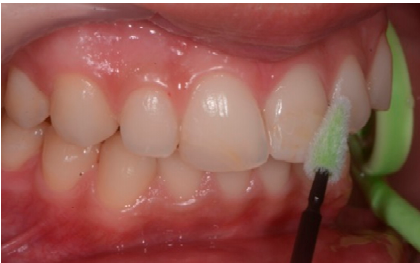
Figure 13. Desensitizing treatment required by the patient.